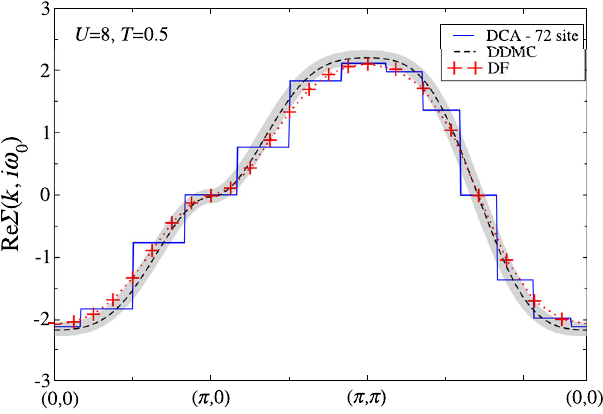
FIG. 16. Comparison of the real part of the self-energy, Re Σ ð k; i ω 0 Þ , at the lowest Matsubara frequency i ω 0 , obtained from DF (red) compared to 72-site DCA calculations (black) plotted as a function of momentum k , throughout the Brillouin zone for n ¼ 1 . 0 , U=t ¼ 8 , T=t ¼ 0 . 5 . The dual fermion and DCA self-energies are plotted as step functions. Also included are interpolated results obtained by diagrammatic determinantal Monte Carlo (DDMC) [120,140,142,143] (dashed black) with a gray shading to indicate the level of uncertainty.